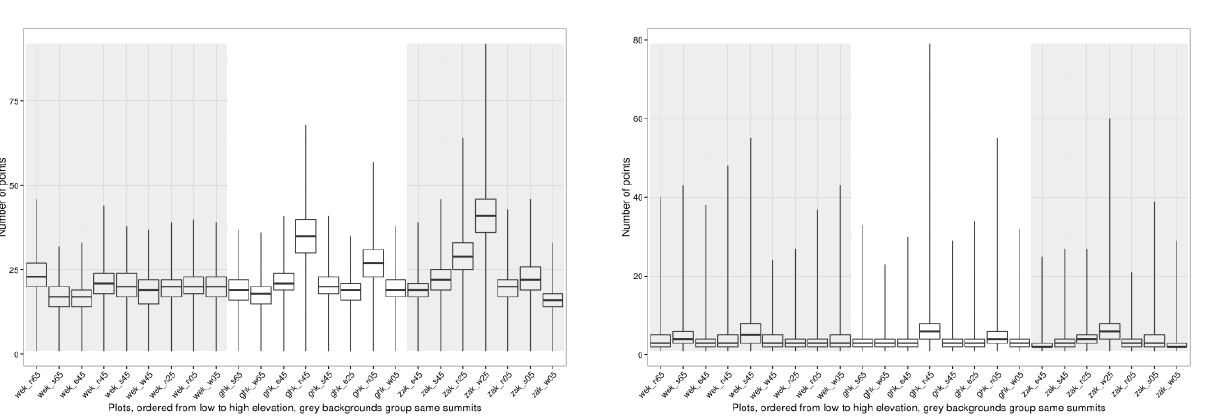
Figure 6. Distribution of points per plot calculated per 1 cm sphere. Vertical lines are the range of all point neighborhoods. Horizontal lines are the median and the box margins represent the 25 th and 75 th quantile. Plot names are abreviations for the summit, the cardinal direction and altitude below the HSP.